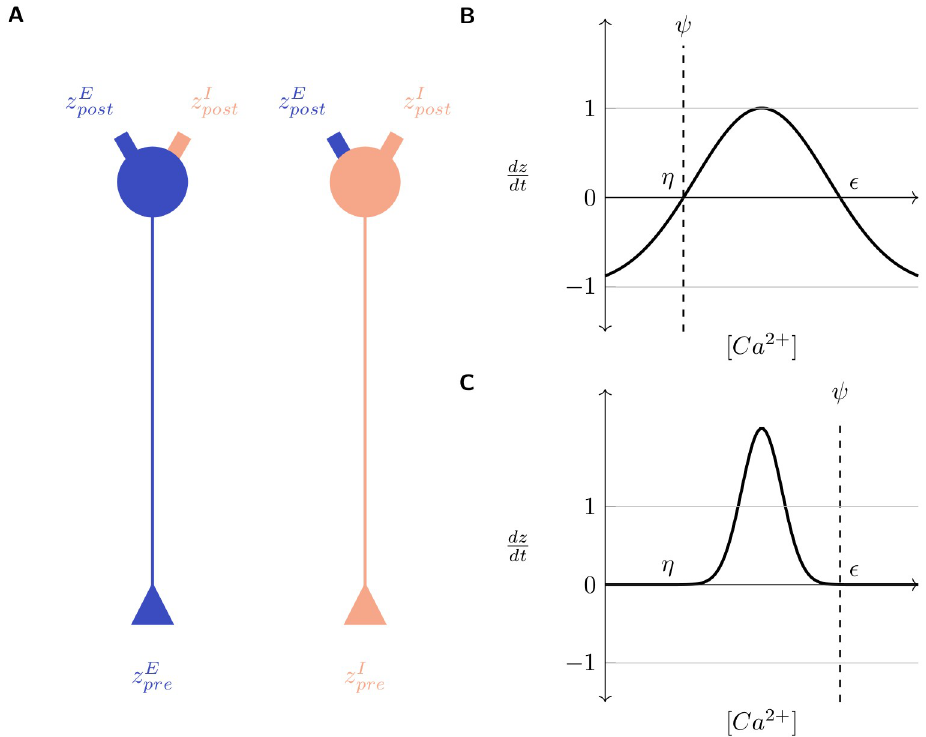
Fig 2. Gaussian growth curves modulate the rate of turnover of synaptic elements ( dz its [ Ca 2+ ]. ( A ) Excitatory: Blue; Inhibitory: Red; All neurons possess excitatory and inhibitory post-synaptic elements ( z E ; z I ) but excitatory and inhibitory neurons can only bear excitatory and inhibitory pre-synaptic elements, post post ; z I ); ( B ) and ( C ). Example Gaussian growth curves. Constants η and � control the width and respectively ( z E pre pre positioning of the growth curve on the x-axis. ω (see Eq 1) controls the positioning of the growth curve on the y-axis. ν (see Eq 1) is a scaling factor. ψ is the optimal [ Ca 2+ ] for the neuron. The minimum and maximum values of dz / dt can be analytically deduced to be − νω and ν (2 − ω ) respectively (see Methods). The relationship between η , � , and ψ regulates the activity dependent dynamics of neurites. ( B ) ψ = η = 5.0, � = 15.0, ν = 1.0, ν = 1.0, − νω = − 1.0, ν (2 − ω ) = 1.0 (see Methods). Here, new neurites are formed when the neuronal activity exceeds the required level and removed when it falls below it. ( C ) η = 5.0, ψ = � = 15.0, ν = 1.0, ω = 0.001, − νω = − 0.001, ν (2 − ω ) = 1.999 (see Methods). Here, the growth curve is shifted up along the y-axis by decreasing the value of ω . New neurites are formed when the neuronal activity is less than the homeostatic level and removed (at a very low rate) when it exceeds